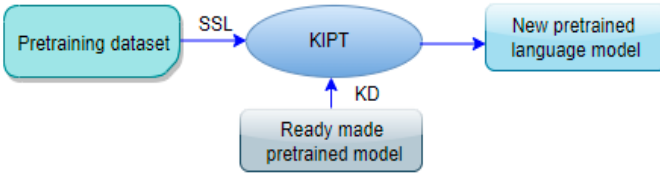
Figure 6. Pretrained model based on knowledge transfer .